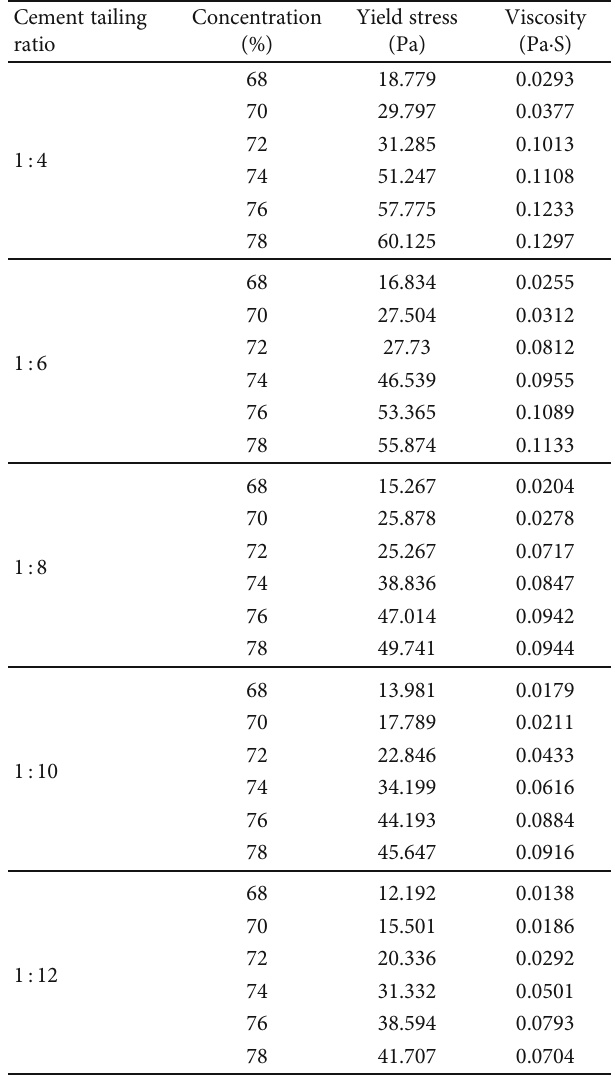
Table 6: Test results of rheological parameters with di ff erent concentrations and ratio of cement